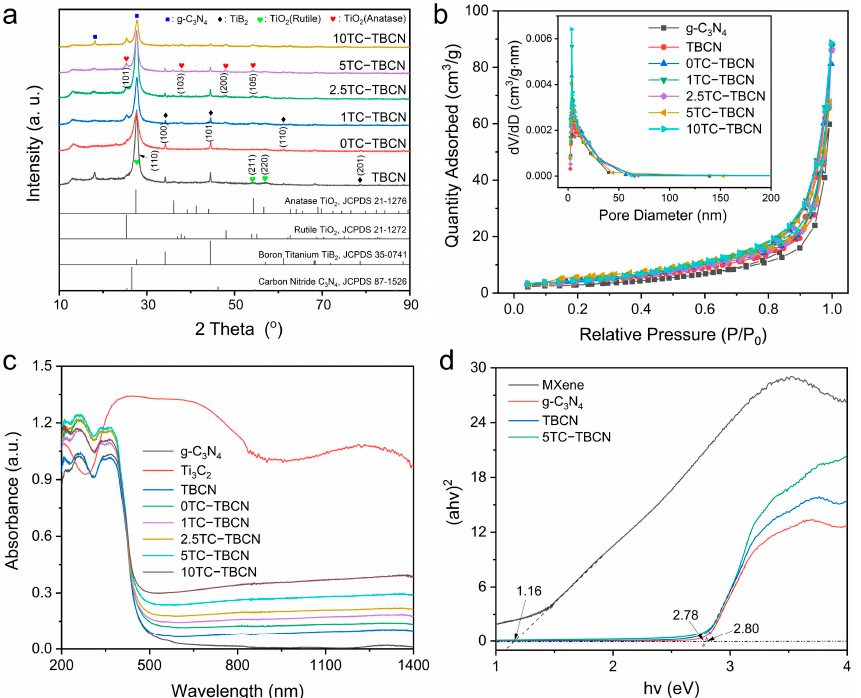
Figure 7. ( a ) XRD patterns, ( b ) N 2 adsorption/desorption isotherms and corresponding pore size distribution curves; ( c ) UV–Vis DRS spectra; ( d ) the estimated bandgap energies for the different samples.